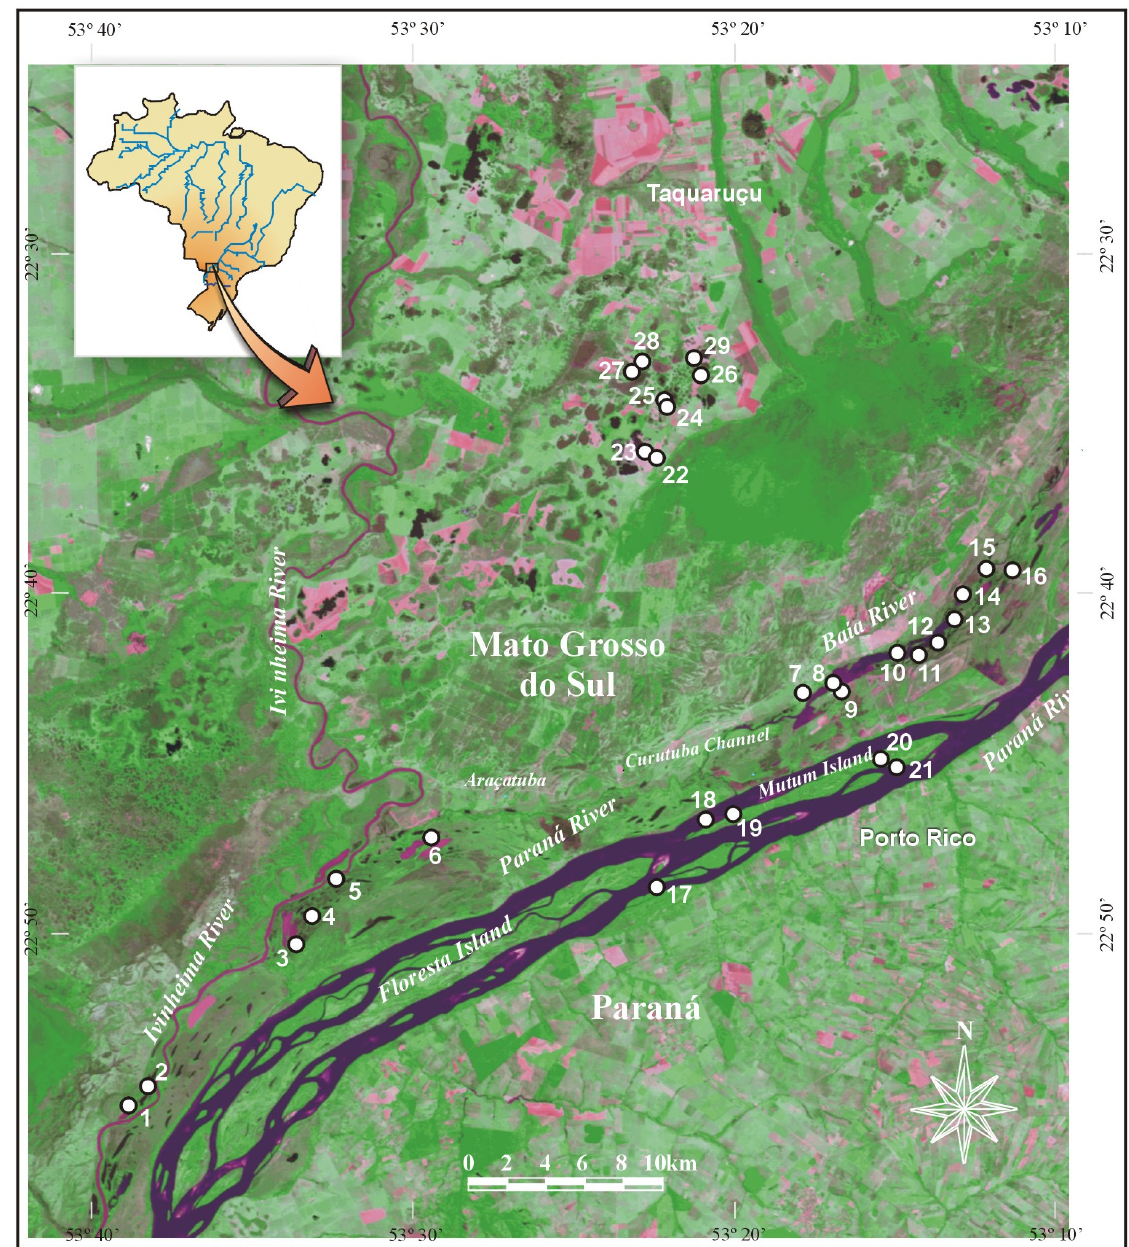
Fig. 1. Map of the area, indicating localities of Candobrasilopsis rochai gen. nov. sp. nov. and C. bra- siliensis (Sars, 1901) comb. nov. were collected. Detailed occurrences are indicated in Table 1. Locality 13 (samples PAR193 and PAR195) is the type locality of C. rochai gen. nov. sp.